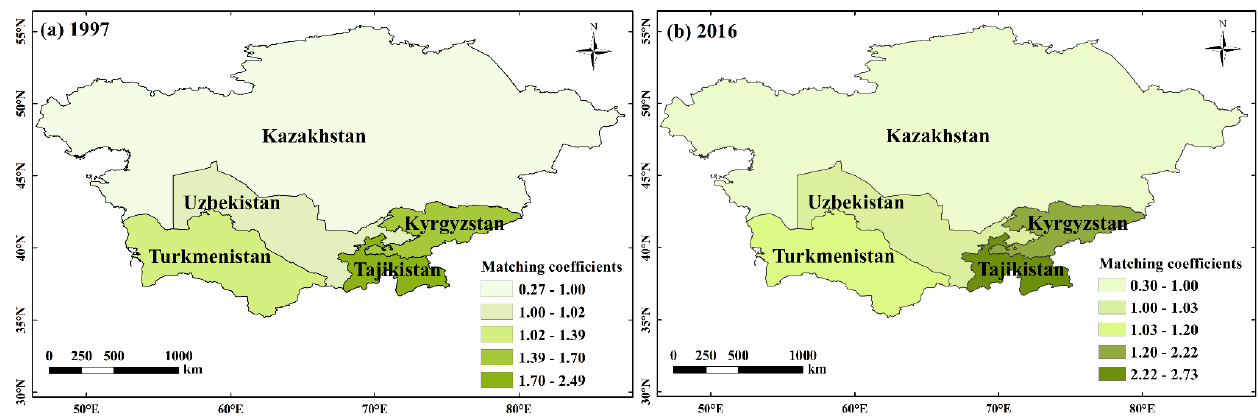
Figure 5. Spatial distribution of matching coefficients of water and land resources in the five Central Asian countries in (a) 1997 and (b) 2016. The country borders are from the National Platform for Common Geospatial Information Services (https://www.tianditu.gov.cn/, last access: 4 December 2020; GS(2016)2948).